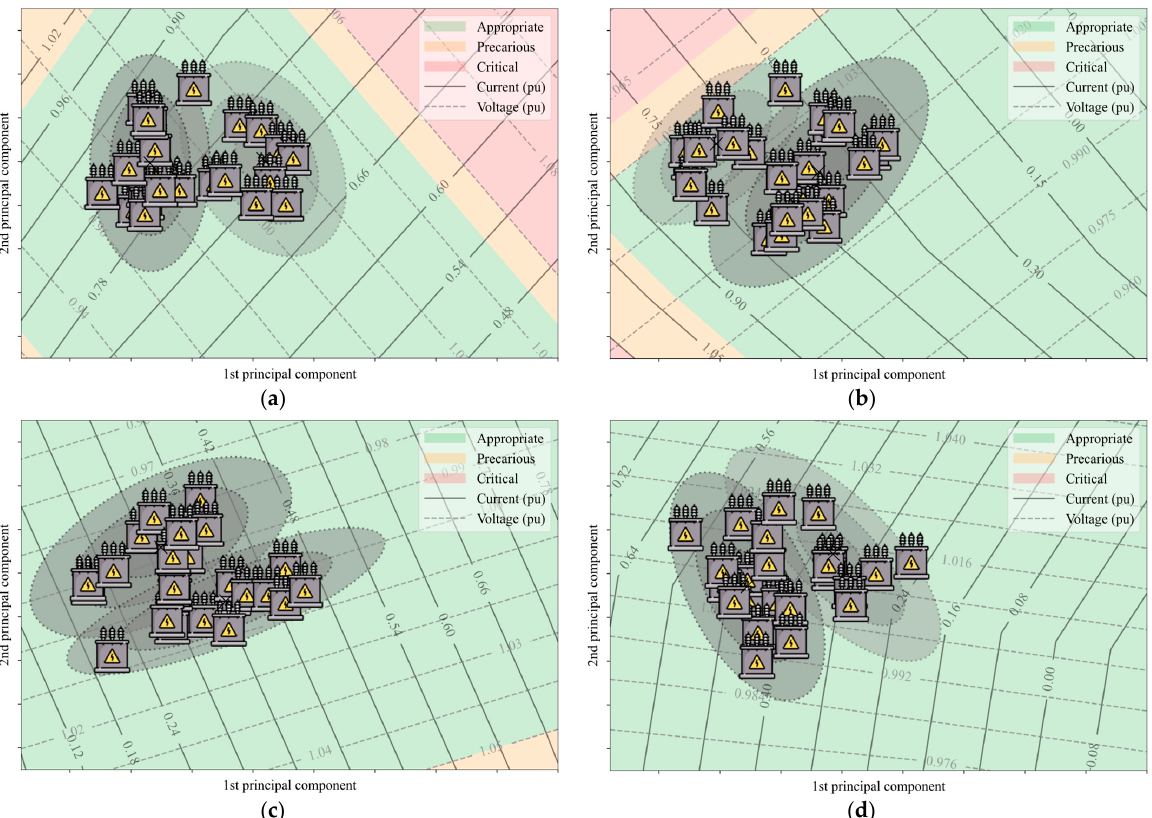
Figure 6. Result from the initialization phase. ( a – d ) show the initial OCMs, the OPs for every hour, as well as the operation map of transformers 2, 3, 4 and 5, respectively.